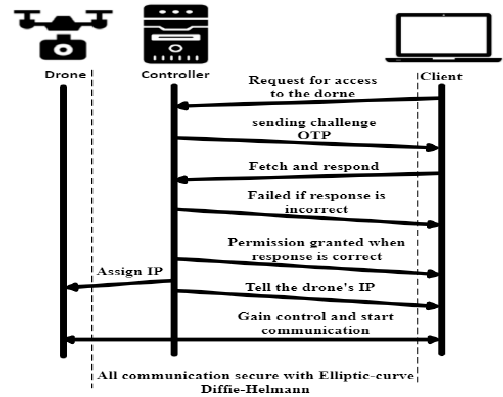
Figure 5. Controller client secured